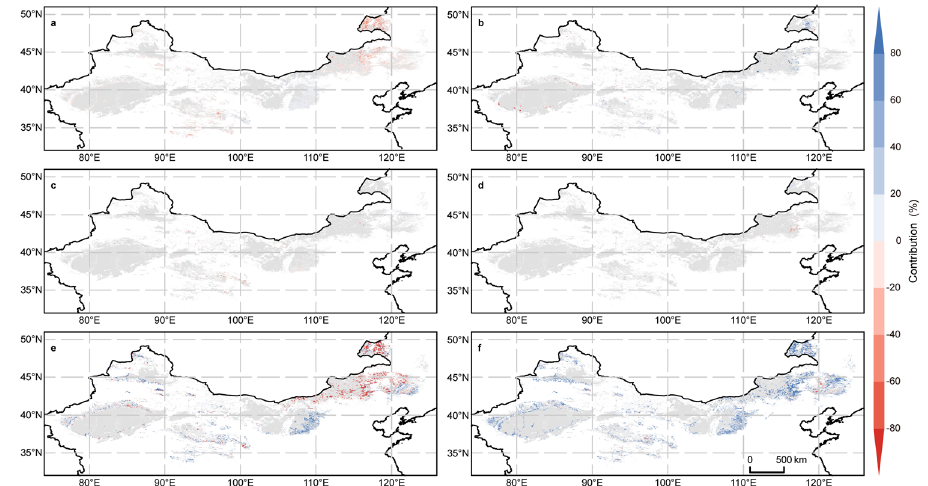
Fig. 2 | The contributions of natural factors to vegetation restoration. Con- tributions of the precipitation a , temperature b , solar radiation intensity c , near- surfacewindspeed d ,andatmosphericCO 2 concentration e tovegetationrecovery in the deserti fi cation-prone region (DPR) and their total contribution f from 2000